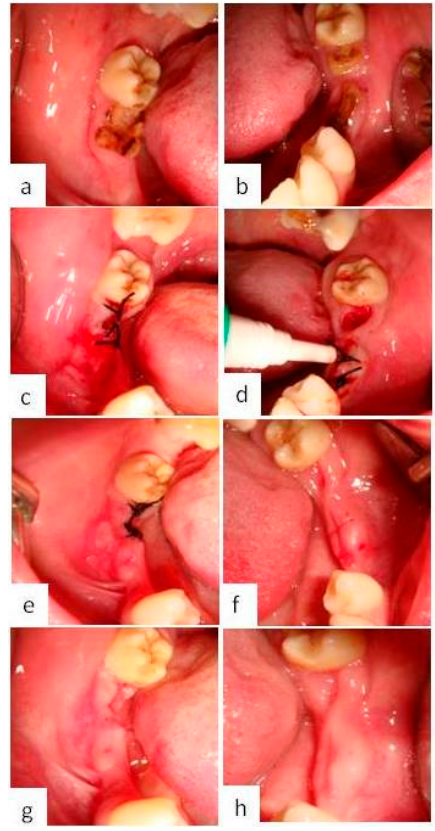
Figure 1. GROUP A: necrotic roots of 4.7 ( a ) and 3.6 ( b ) removed with margins closure by stitches ( c , d ). Aminogam ® gel was applied within the alveolar socket and upon stitches only on the left side ( d ) After 5 days, stitches were removed exclusively on the left side ( f ), while the right one showed signs of flogosis and uncompleted healing ( e ). After 8 days, 3.6 site showed sockets closure and gingival healing ( h ), while stitches were removed by 4.7 socket which still appeared to be not completely healed ( g ).